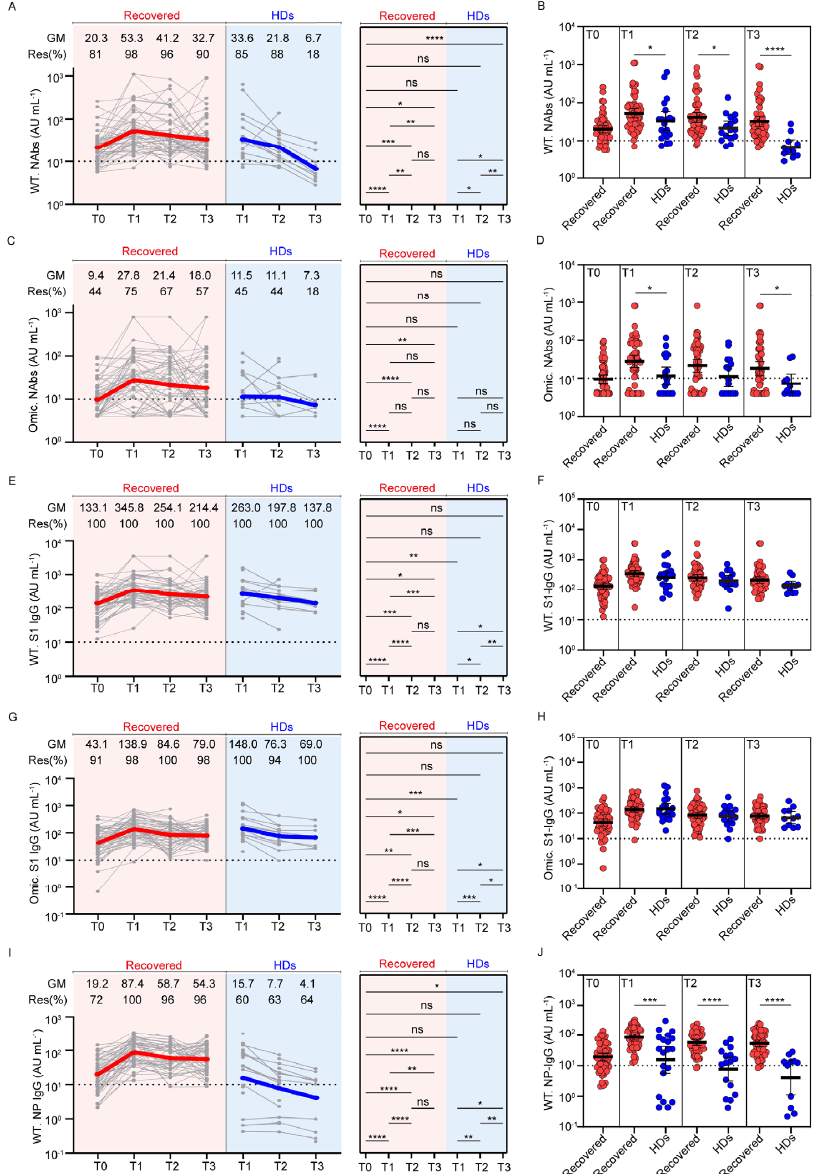
Figure 2. Dynamic changes of virus-specific antibodies in individuals with previous SARS-CoV-2 infection and healthy donors. The left parts show dynamic changes in NAbs against wild-type strain ( A ), NAbs against Omicron ( C ), Spike S1 domain-specific antibodies against wild-type strain ( E ), Spike S1 domain-specific antibodies against Omicron ( G ), and nucleoside protein-specific IgG antibodies against wild-type strain ( I ) in two cohorts over the different timepoints. Individuals are shown as gray symbols with connecting lines for longitudinal samples. Geometric means are shown in thick, colored lines: individuals with previous SARS-CoV-2 infection are color-coded in red and healthy donors in blue. The right parts show the comparison of antibodies between different time points. The scatter diagrams show the comparison of NAbs against wild-type strain ( B ), NAbs against Omicron ( D ), Spike S1 domain-specific antibodies against wild-type strain ( F ), Spike S1 domain-specific antibodies against Omicron ( H ), and nucleoside protein-specific IgG antibodies against wild-type strain ( J ) between individuals with previous SARS-CoV-2 infection and healthy donors at 3, 6, and 9 months post-vaccination. Dotted lines indicate the cut-off value. Statistics were calculated using Wilcoxon’s signed-rank test for paired groups and Mann–Whitney U test for unpaired groups: * p < 0.05; ** p < 0.01; *** p < 0.001; **** p < 0.0001. GM, geometric mean; Res, responders; NAbs, neutralizing antibodies; WT, wild-type strain; Omic,